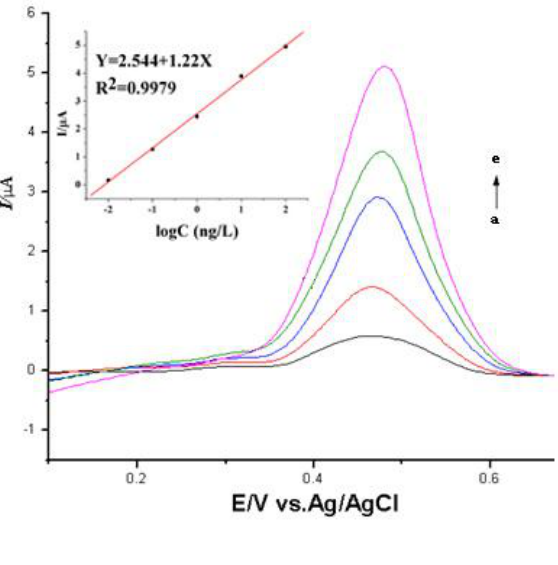
Figure 4. The decrease in anodic currents subtracted from the sameconditions of PBS substance was proportional to the logarithm of the trypsin concentrations, a→e indicate of the trypsin concentrations 0.01 ng, 0.1 ng, 1 ng, 10 ng, and 100